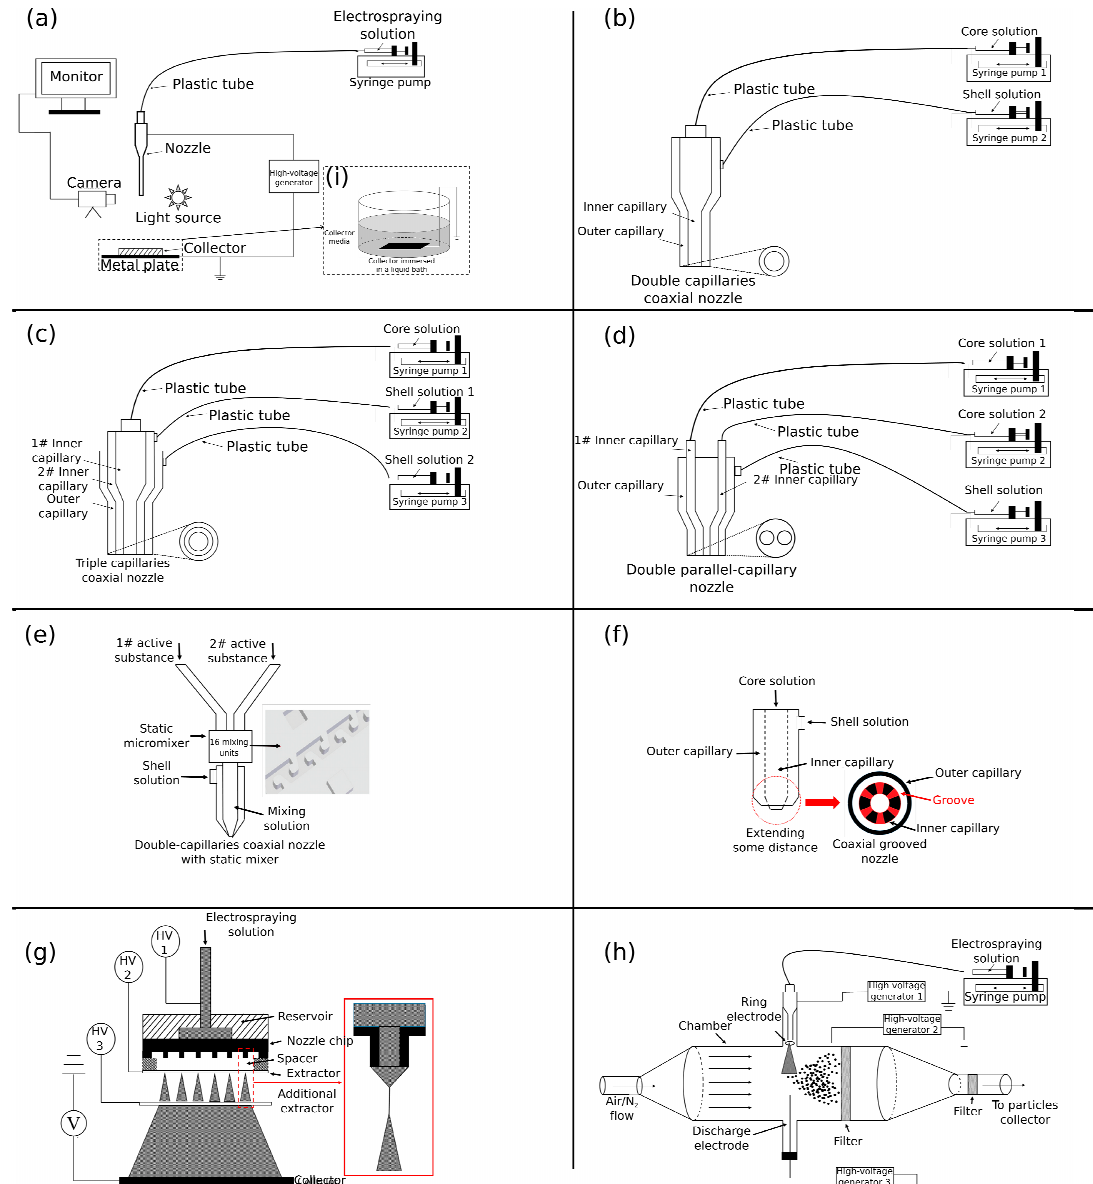
Figure 2. Common examples of electrospraying apparatus, ( a ) single-capillary electrospraying, ( b ) double-capillaries coaxial nozzle, ( c ) triple-capillaries coaxial nozzle, ( d ) double parallel-capillaries coaxial nozzle, ( e ) double parallel-capillaries coaxial nozzle with static micromixer, ( f ) double-capillaries coaxial nozzle with grooved structure, ( g ) multiplexed electrospraying setup with several electrospray sources operating in parallel and an extractor, ( h ) electrospraying via a nozzle-ring setup inside a glass chamber under air flow, and ( i ) electrospraying device with liquid bath collector (modified from [37,40,65,89–94]).